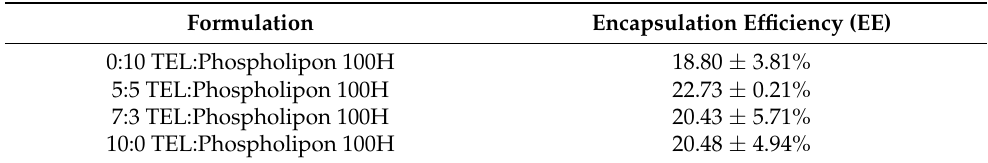
Table 4. The encapsulation efficiency (EE) of liposomes composed of tetraether lipids (TEL) and Phospholipon 100H (Ph) in different molar ratios (0:10, 5:5, 7:3, 10:0; TEL:Ph).